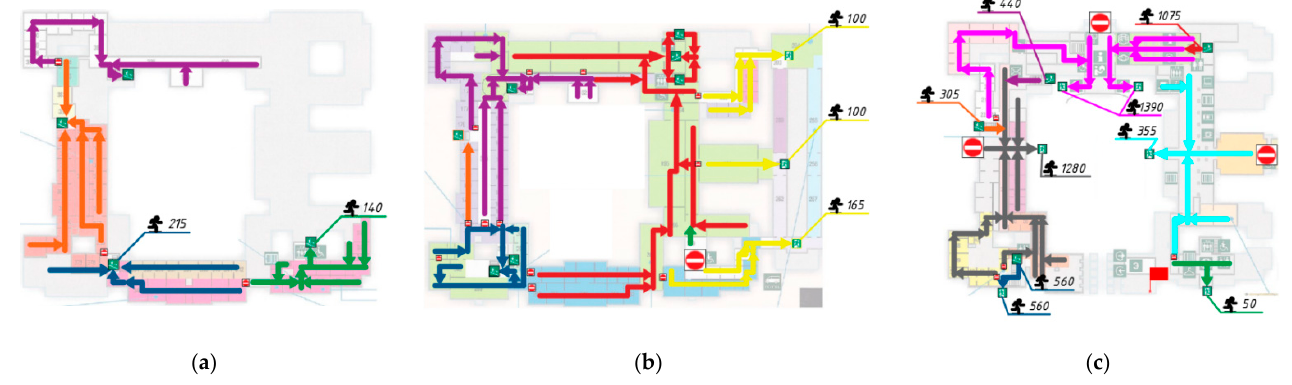
Figure 15. Scheme of evacuation of people from the Winter Palace for the scenario “Fire in the Commandant’s Cloakroom”: ( a ) for the 3rd floor; ( b ) for the 2nd floor; and ( c ) for the 1st floor.